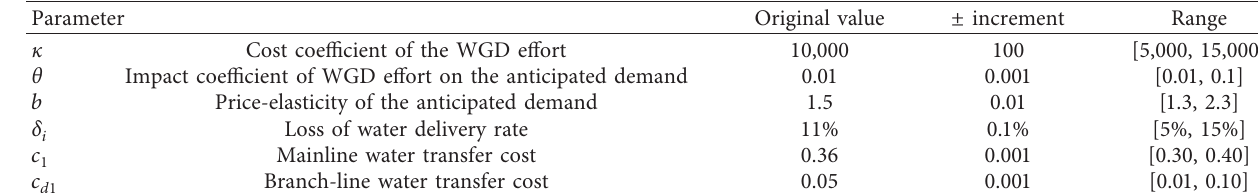
Table 10: Range of key parameter for sensitivity